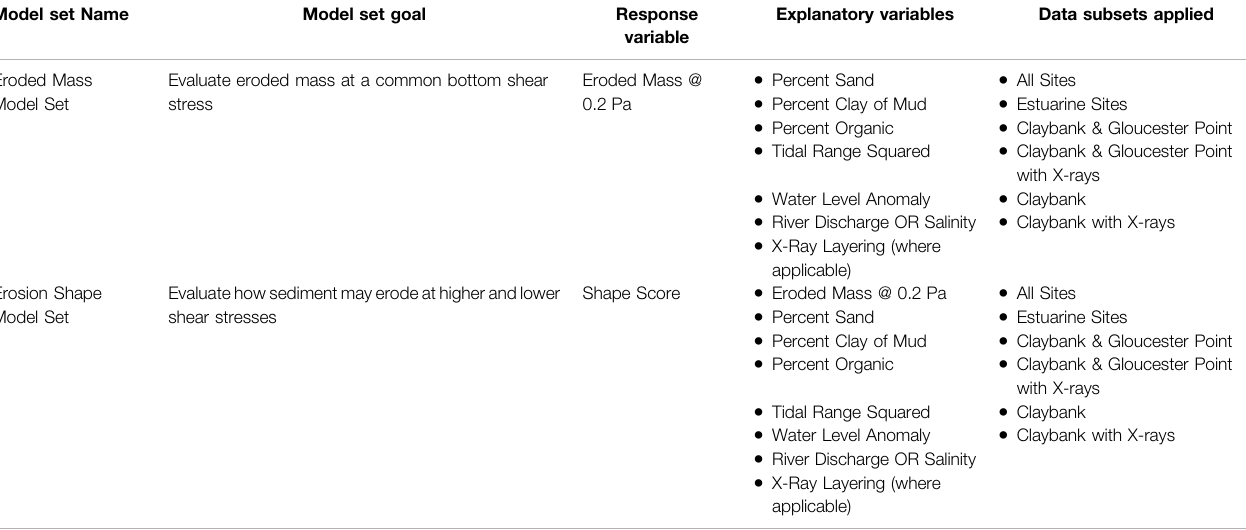
TABLE 3 | Model set and data subset framework for multiple linear regression analysis. Model set